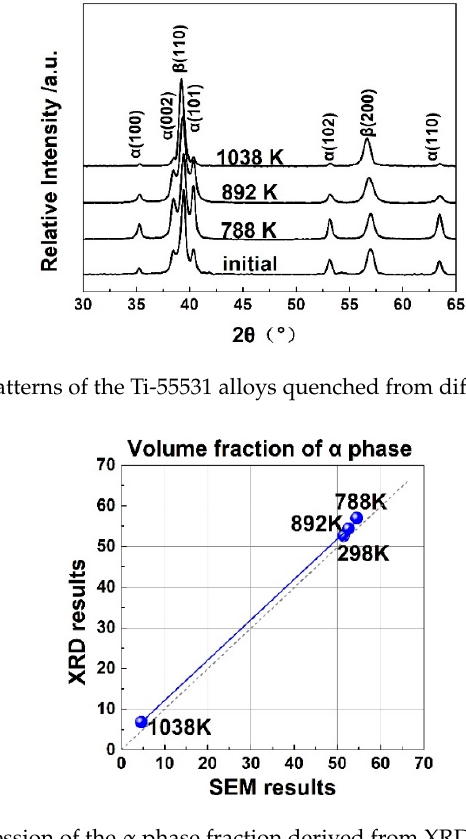
Table 2. Microstructure features of Ti-55531 alloy quenched from different temperatures.